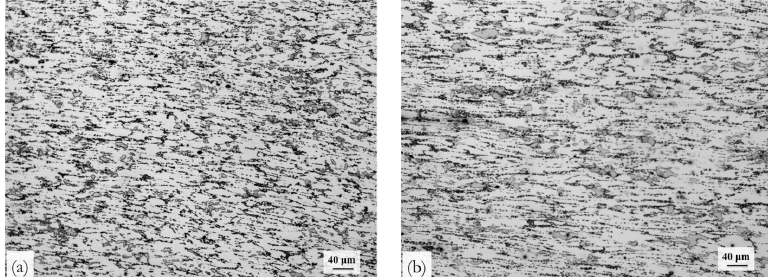
Figure 9. Optical microstructures (the compression axis is vertical) of the ABaX633 alloy deformed at ( a ) 500 °C /0.01 s − 1 , and ( b ) 500 °C/0.1 s − 1 (Domain 2).